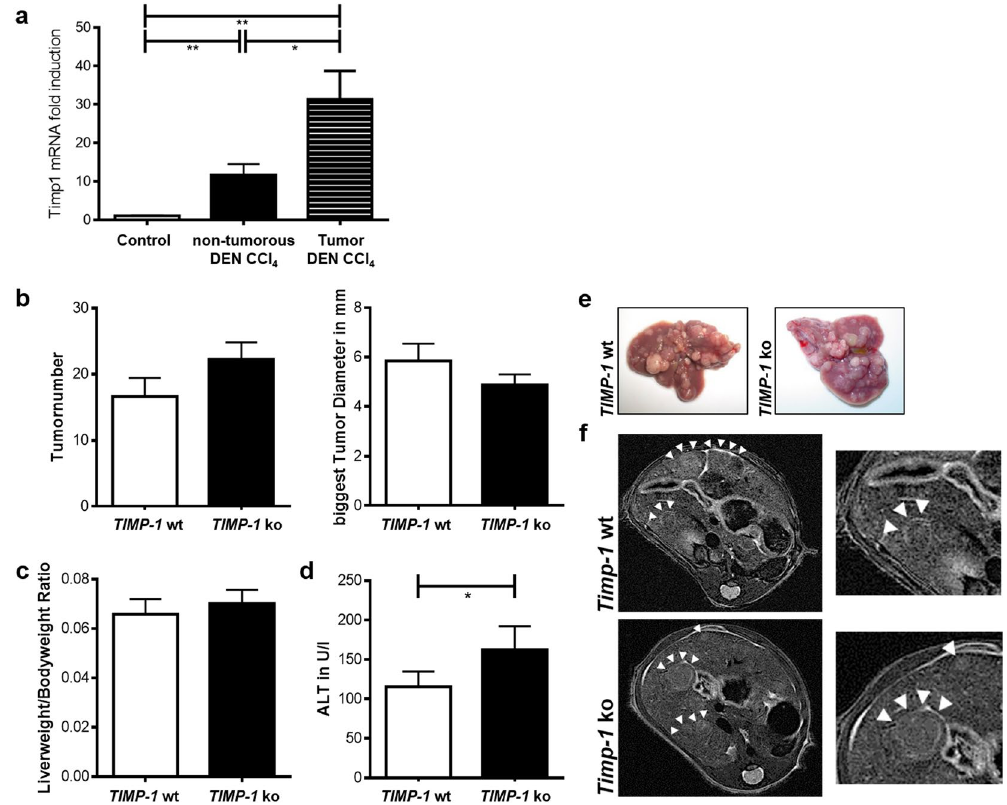
Figure 5. TIMP-1 deficient mice are not protected from fibrosis-driven hepatic carcinogenesis. ( a ) TIMP-1 expression increased in HCC tissue compared to adjacent paired normal tissue and control liver tissue following juvenile DEN administration and chronic CCl 4 injection. ( b ) Tumorload does not differ between TIMP-1 wt and ko as assessed by tumor number and size and ( e ) visualized by representative pictures of excised livers and ( f ) in vivo MRI images. ( c ) TIMP-1-deficiency does not alter the liverweight/bodyweight ratio. ( d ) A combination of juvenile DEN administration and chronic CCl 4 treatment led to overall increased ALT level, whereas elevated level could be measured in serum from TIMP-1 ko mice as compared with TIMP-1 wt. Bar columns represent mean ± standard error of the mean. ** p < 0.01; * p < 0.05. (n =